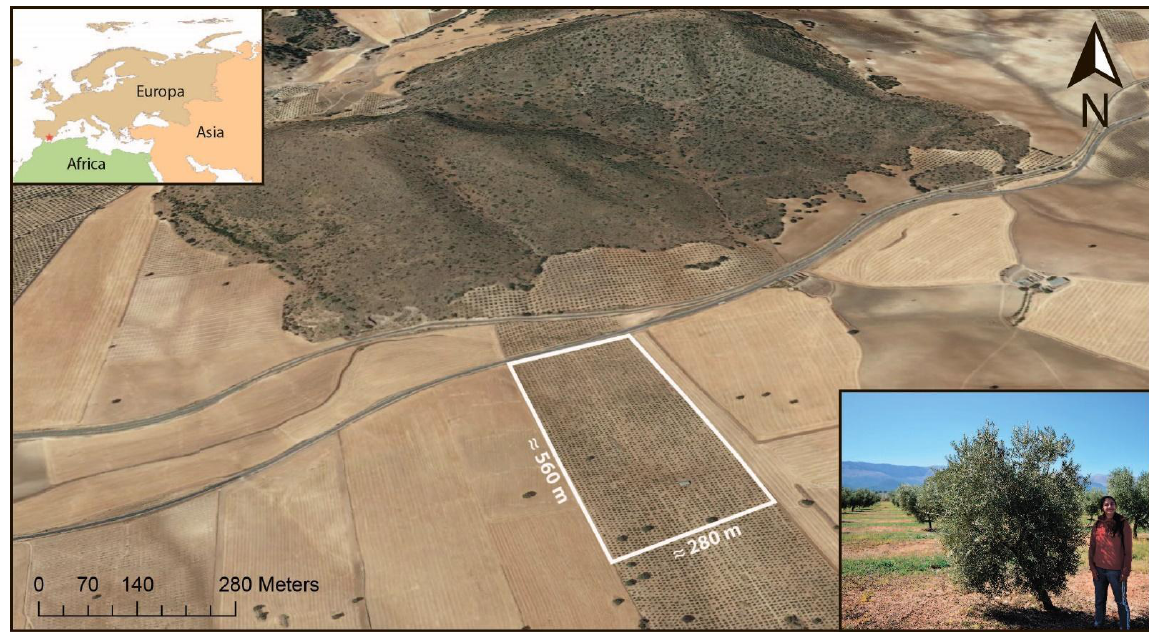
Figure 2. The test area in Andalusia, southern Spain (37°23 ′ 57 ″ N 3°24 ′ 47 ″ W).